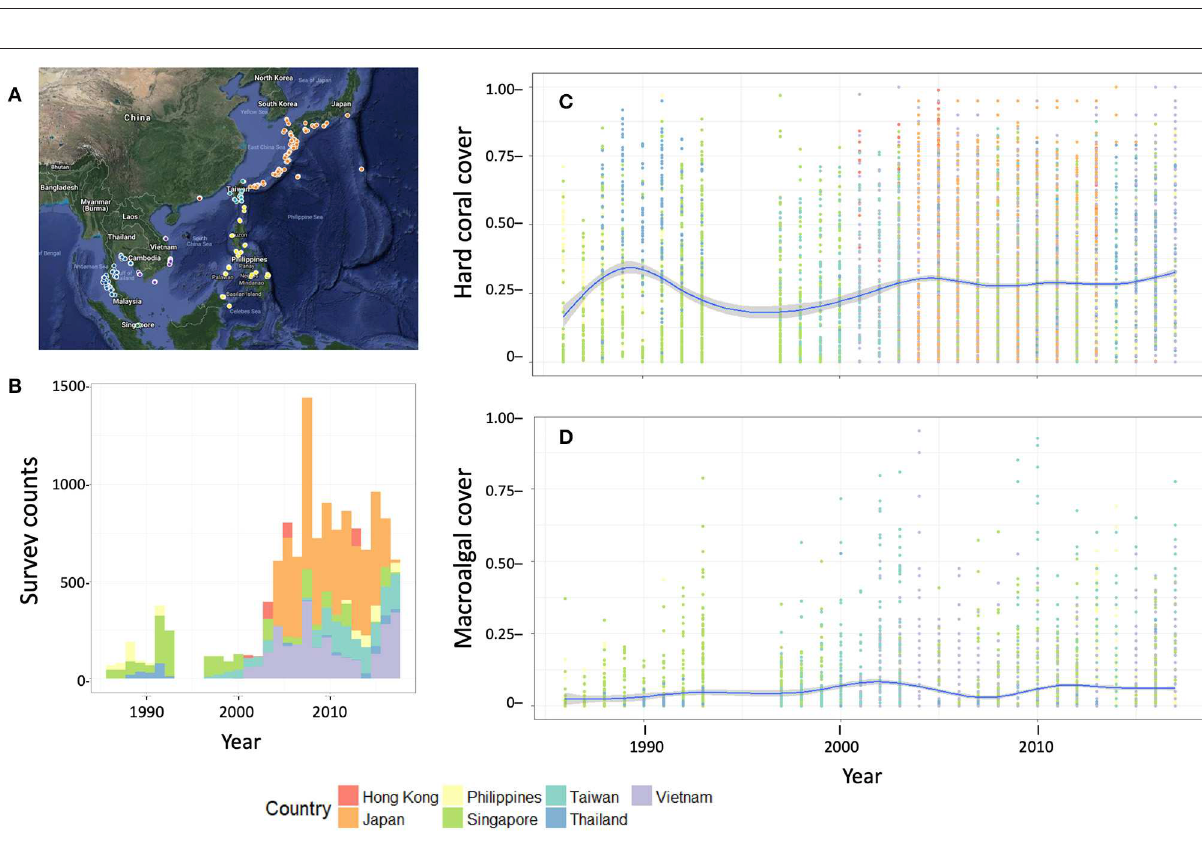
Frontiers in Marine Science |